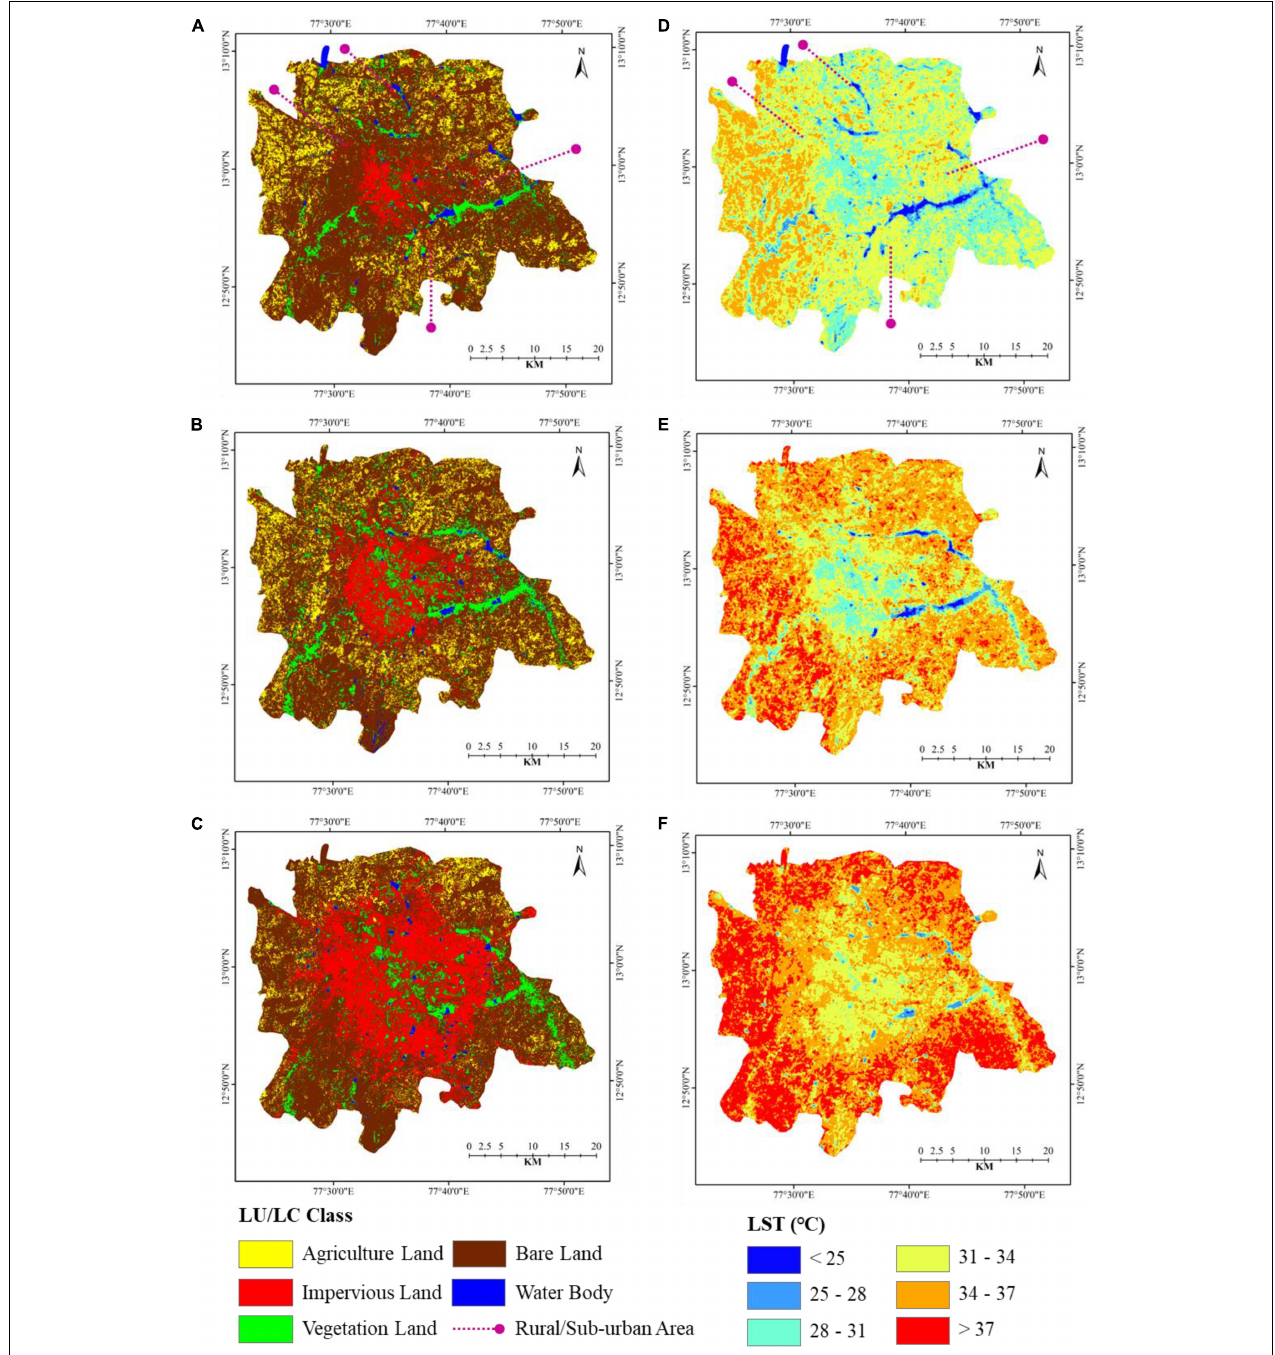
FIGURE 3 | Land use/land cover maps and LST maps for depicting the spatial distribution of SUCI in Bengaluru megacity: (A) LU/LC in 1989; (B) LU/LC map in 2004; (C) LU/LC map in 2019; (D) median LST ( ◦ C) of summer timepoints in 1989; (E) median LST ( ◦ C) of summer timepoints in 2004; and (F) median LST ( ◦ C) of summer timepoints in